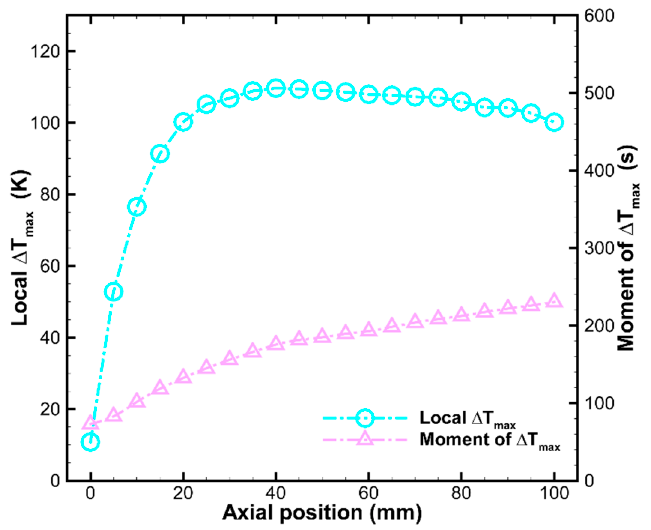
Figure 16. The local maximum ∆ T ( left ), and the moment to reach the maximum temperature ( right ) with various axial positions in the bed.